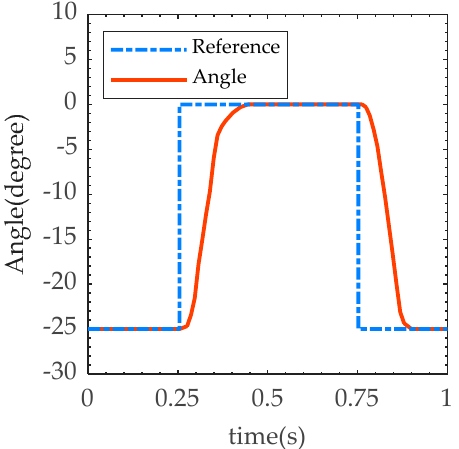
Figure 6. Result of fast response test.